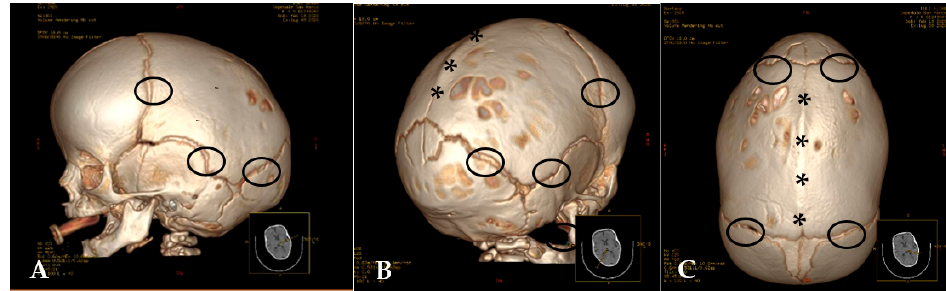
Figure 3. ( A – C ) CT 3D-Reconstructions ( A ) Scaphocephaly with patent sutures (ring); ( B , C ) Patent sutures (ring) and synostotic sagital suture